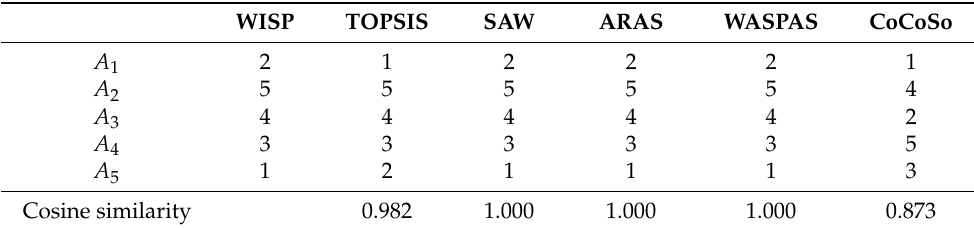
Table 9. The ranking orders obtained based on the fourth decision-making matrices.